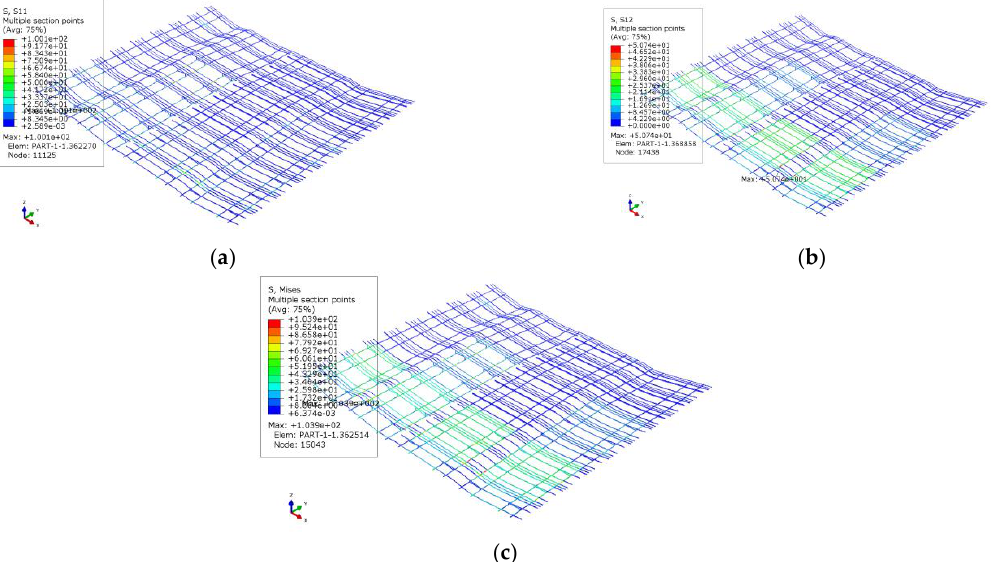
Figure 9. Stress distribution for the case M2-S1 (even mass and wave incident angle 0°): ( a ) normal stress; ( b ) shear stress; ( c ) von Mises stress.